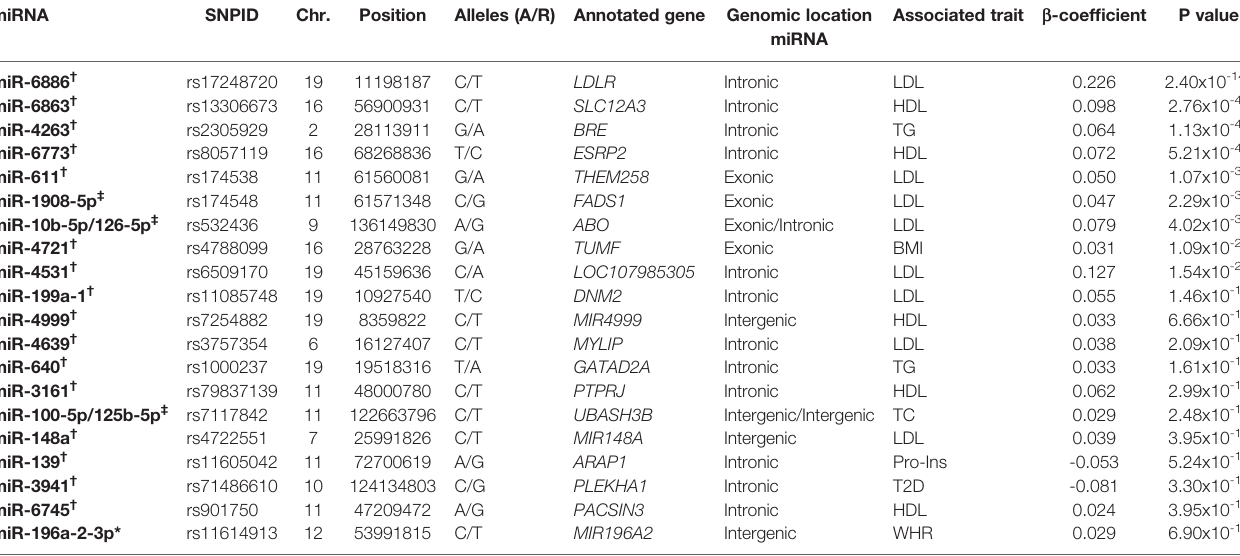
TABLE 2 | The top 20 miRNAs with single-nucleotide polymorphisms (SNPs) in related regions association with cardiometabolic traits.